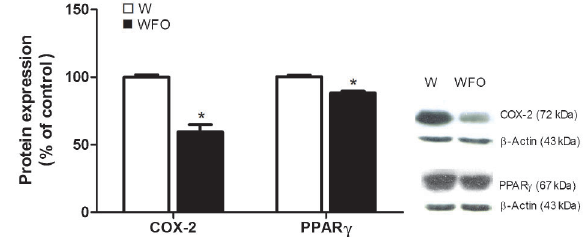
Figure 1. Protein expression of COX-2 and PPAR c in tumor tissue from rats fed a regular chow diet (W) or a regular chow diet supplemented with fish oil (WFO). Anti- b -actin was used as a loading control. Data are reported as means±SE of n=7 (W) and n=8 (WFO) rats from three independent experiments. *P , 0.05 vs W (Student t -test).